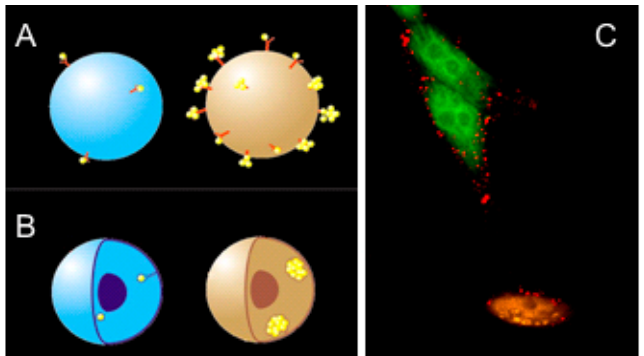
Figure 4. The mechanism of NP targeting (( a ) gold conjugates with cell-specific antibodies target the matching receptors, ( b ) membrane-located NPs are endocytosed and selectively form NP clusters in cells with sufficient amounts of NPs) and laser confocal scattering and fluorescent images of the target (green) and normal (amber) cells, ( c ) optical scattering by gold NPs is shown in red: Only the target cell (green (treated with AlexaFluor 488)) built several large NP clusters while the normal cell (amber (treated with AlexaFluor 546)) non-specifically accumulated some NPs without creating large NP clusters.